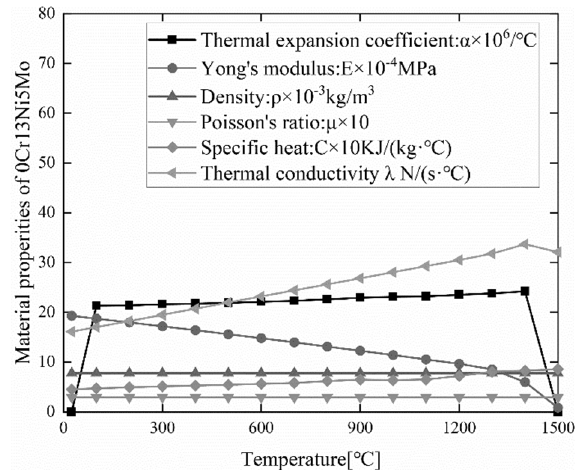
Figure 6. Thermal and mechanical properties of 0Cr13Ni5Mo.